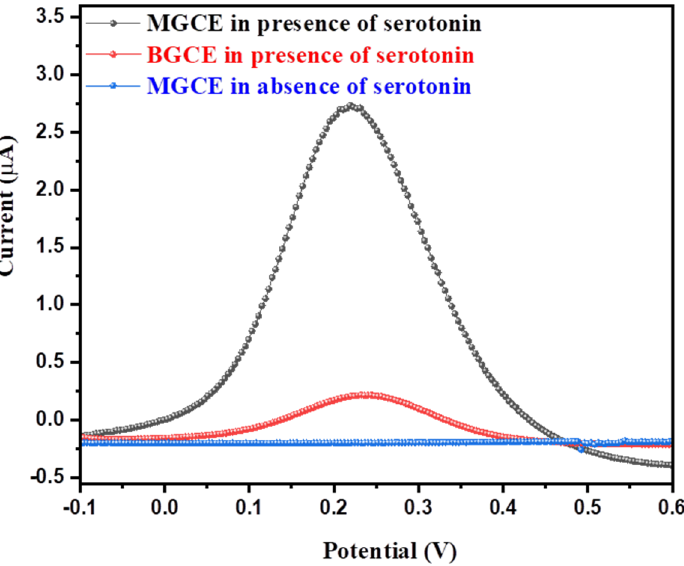
Figure 8. DPVs of BGCE and MGCE in absence and presence of 2 µM serotonin in 0.1 M PBS (pH = 7.0) at scan rate of 50 mV/s.